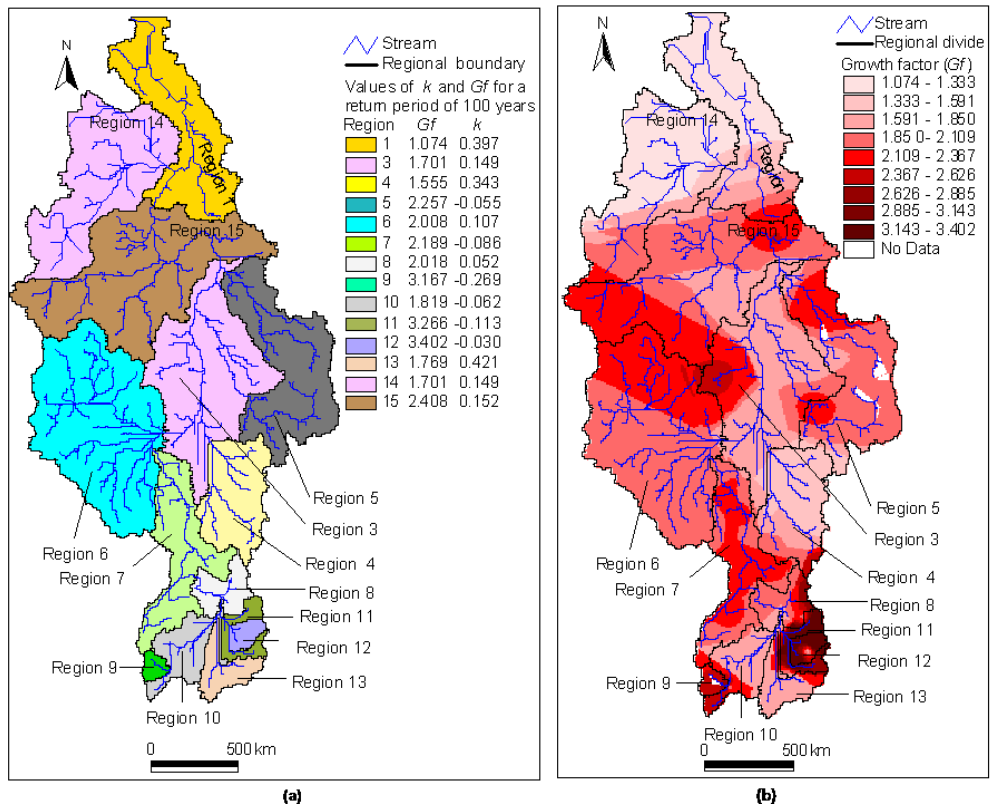
Fig. 9. Variation in regional growth factor for 100yr return period (Gf 100 ) simulated using GEV distribution, and the regional shape parameter ( k) in the River Nile basin: (a) constant value of (Gf 100 ) in a region (b) value of Gf 100 varies over a